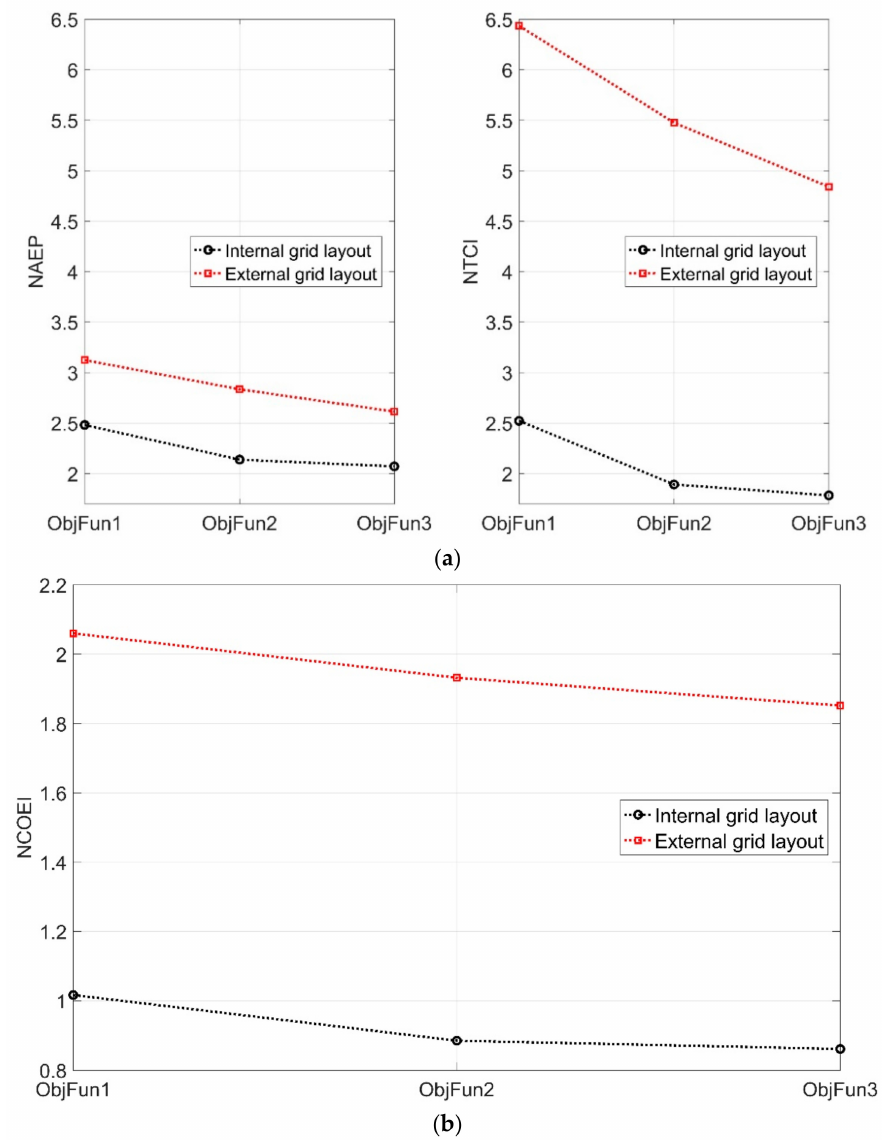
Figure 11. Results for multiple turbines grid layouts. ( a ) Normalized annual energy production and normalized total cost index; ( b ) Normalized cost of energy